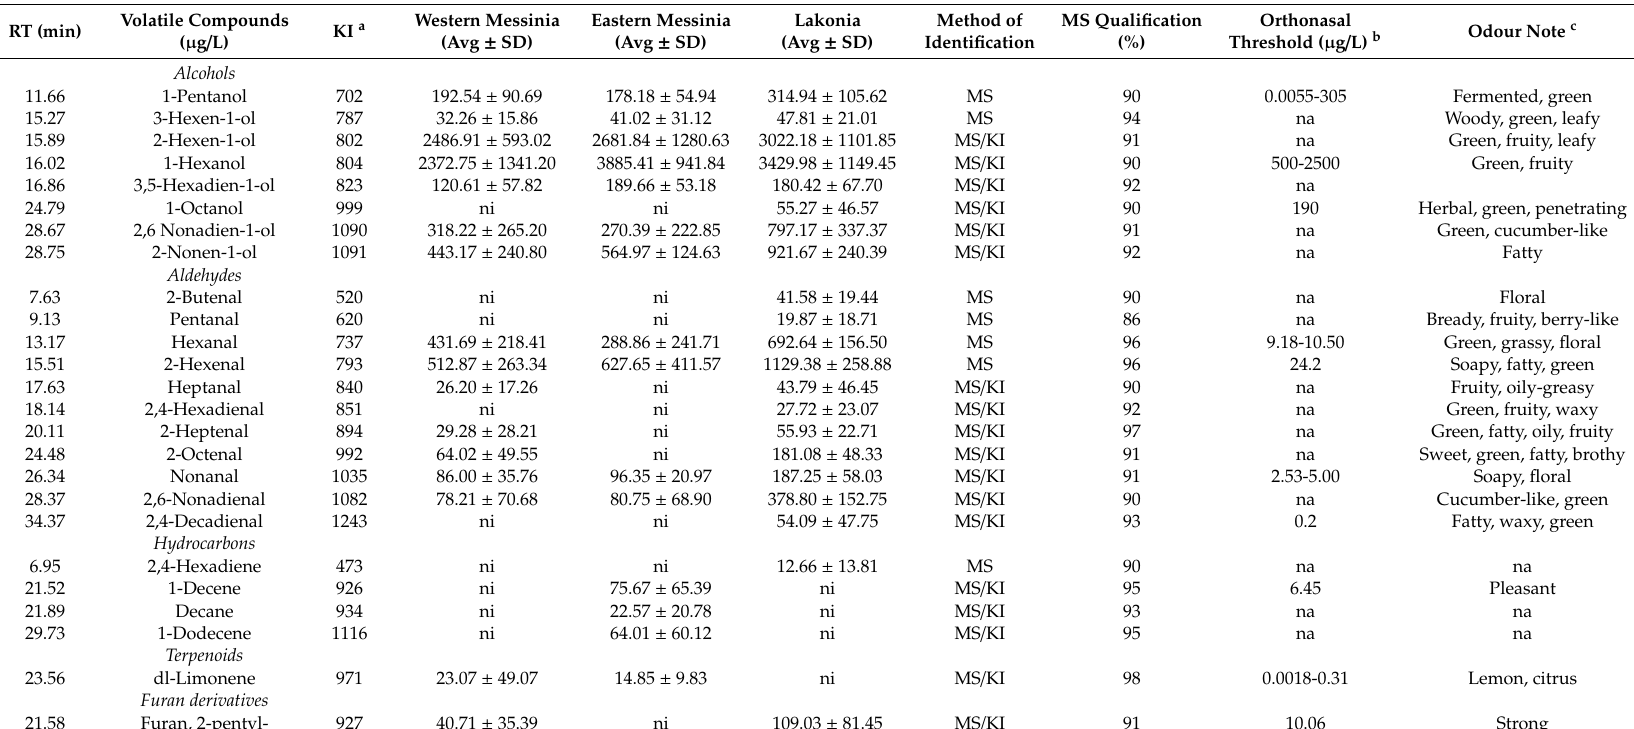
Table 2. Volatile compounds of prickly pear juice tentatively identified and semi-quantified according to geographical